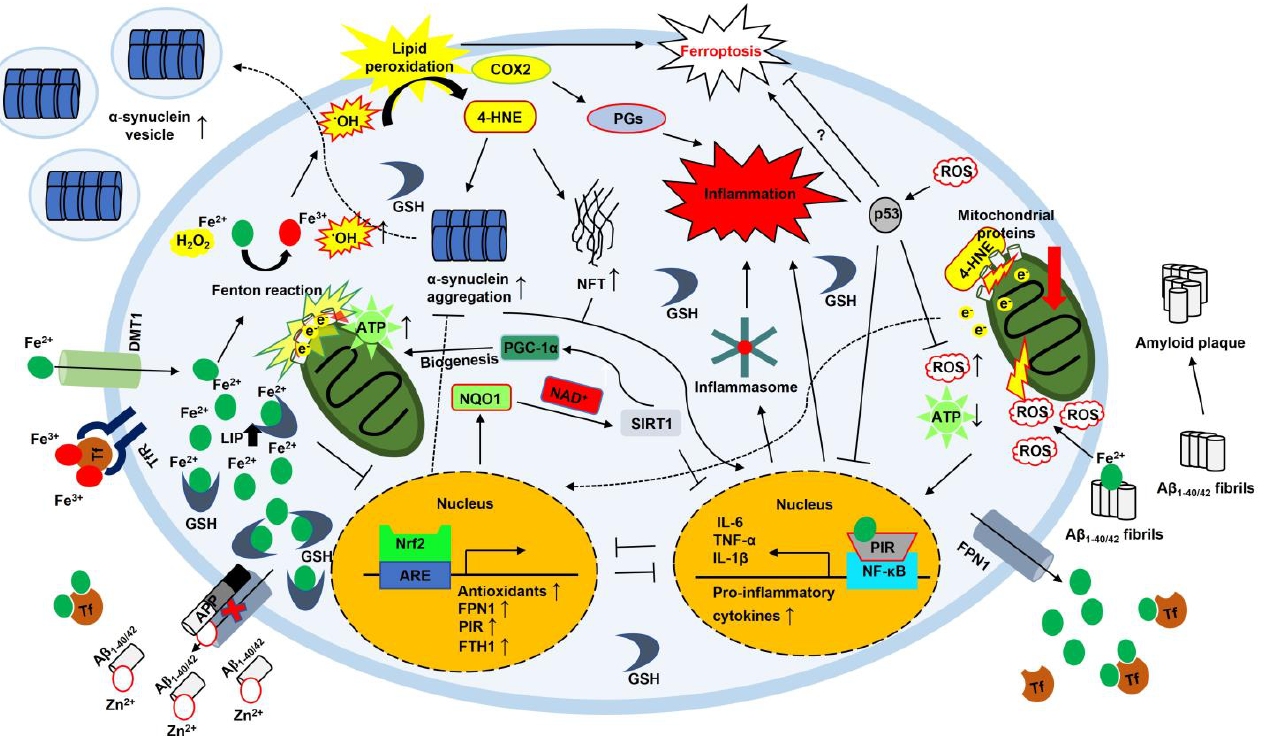
Figure 4. The interplay between iron homeostasis and inflammation in AD and PD.